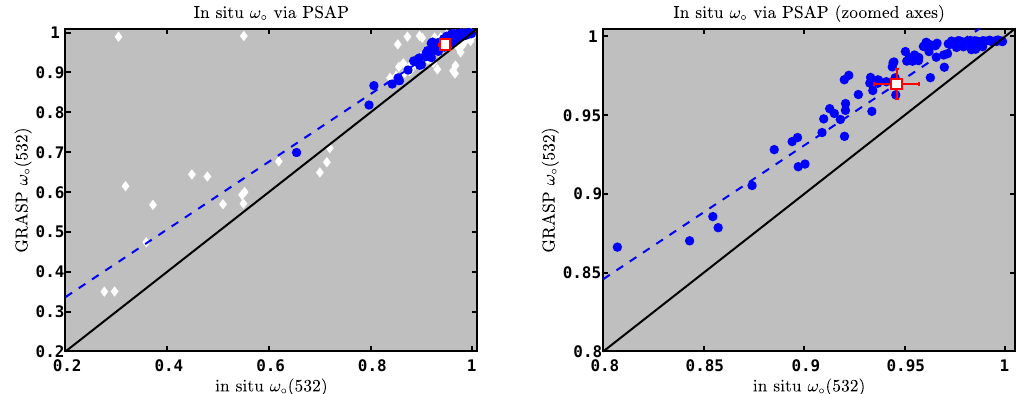
Figure 4. Comparison of single-scatter albedo derived using GRASP to ω ◦ derived directly from PSAP absorption and CAPS extinction measurements. GRASP retrievals use scattering angles identical to data with solar zenith angles of 50 ◦ in the AERONET database. Blue circles indicate GRASP retrievals that have residuals of less than 8%, while white diamonds in the left panel indicate the additional scatter that occurs when residuals are not restricted. Red square is the mean value, and error bars represent two standard deviations of the mean. Data in the right panel is identical to blue circles in the left panel, but the axis ranges are different. In situ ω ◦ were determined using CAPS extinction measurements and PSAP absorption measurements. Solid lines are 1:1 and dashed blue lines correspond to linear regression of the blue circles; statistics are presented in Table 2. Table 2. Linear regression statistics for single-scatter albedo using different in situ measurement techniques. The first row of numbers corresponds to Figure 4, 4th and 7th rows correspond to Figure